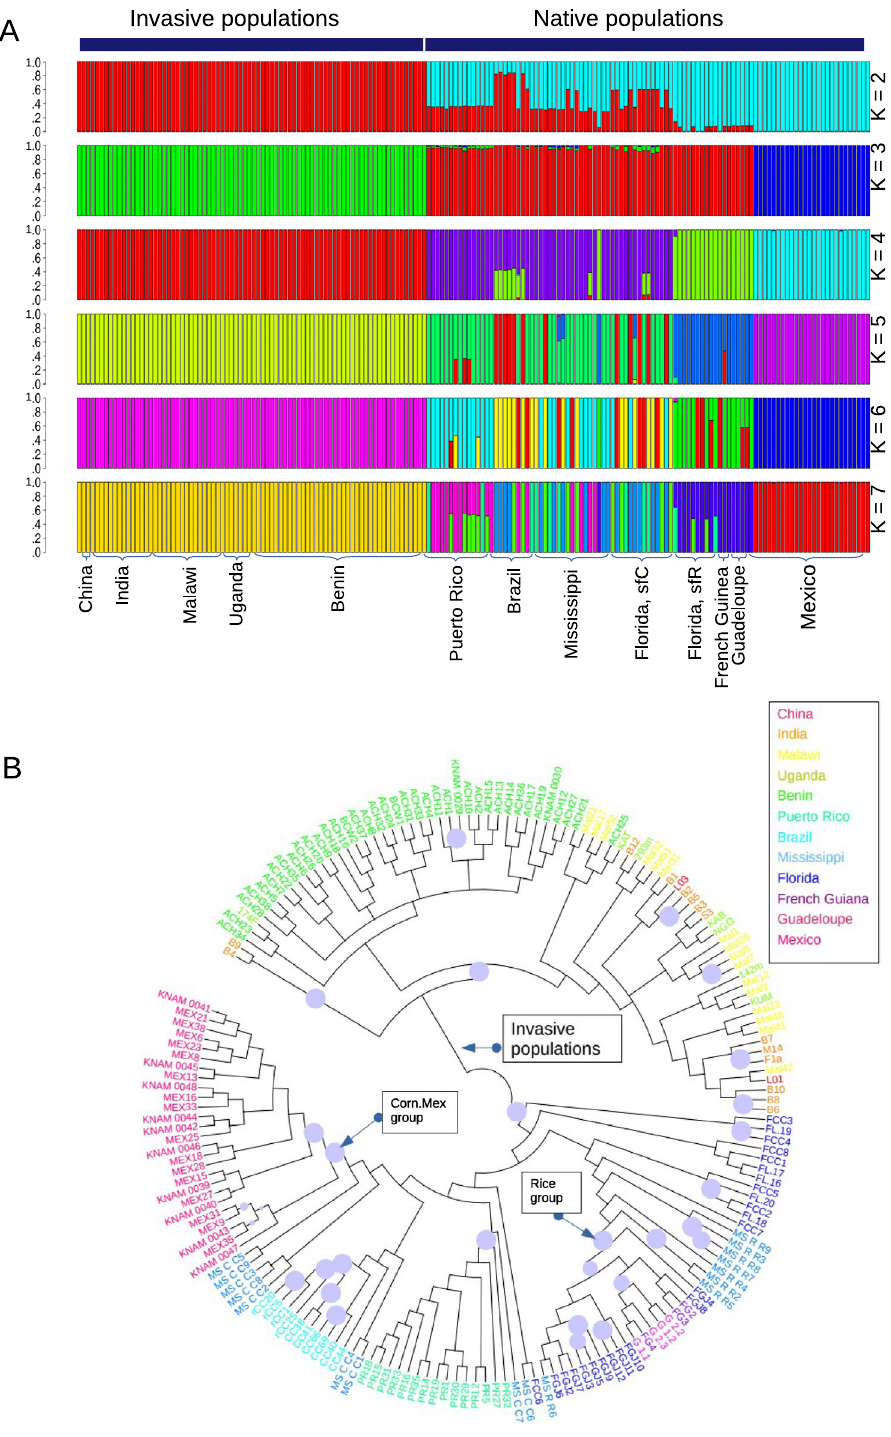
Figure 3. A single origin of invasive populations ( A ) Ancestry coefficient analysis from SNVs showed homogeneous genomic sequences of invasive populations. ( B ) A nuclear BIO-NJ phylogenetic tree was reconstructed from whole nuclear genome sequences. The circles on the branches show bootstrap support values higher than 90%. The Corn.Mex group and the Rice group are indicated to the corresponding nodes. The remaining individuals belong to the Corn Group. Invasive individuals were also indicated to the corresponding node. The phylogenetic tree was visualized using iTOL v4 52